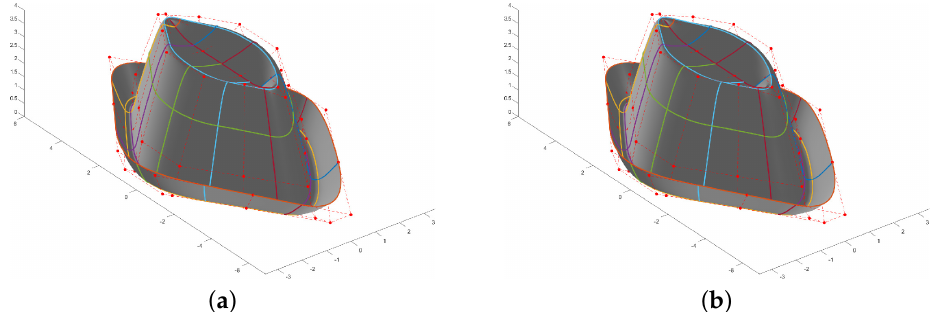
Figure 8. ( a ) Tensor product and ( b ) triangulated surfaces with R = m = 8, S = 4, n = 5, 0,0,0,1 8,9,9,9 , V = 0,0,0,1 5,6,6,6 , being the barrier at knot v 3 . The network control U = { ÷ } { ÷ } points are taken from Test 3 of [26].